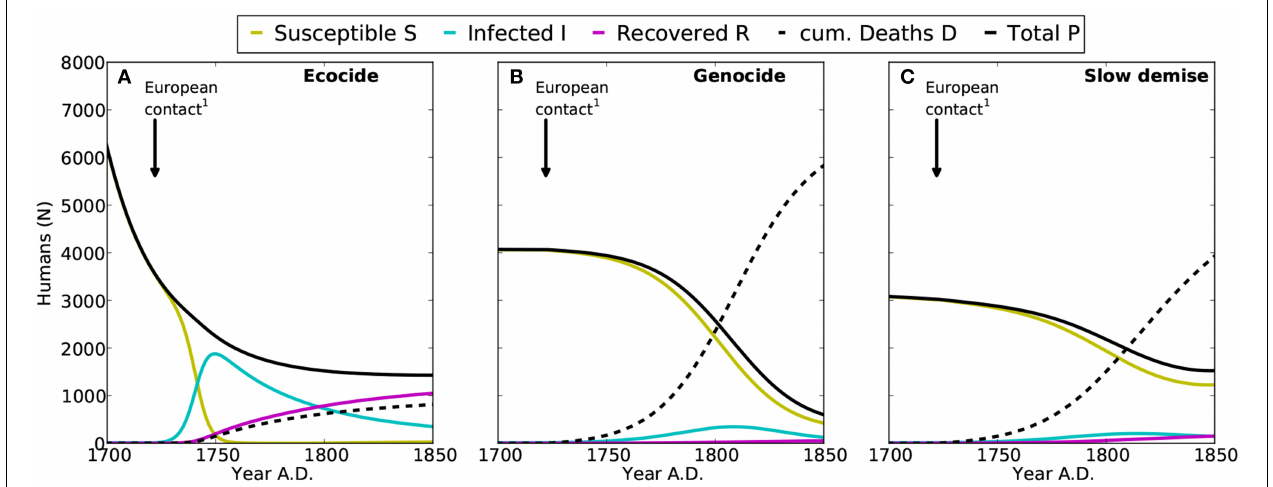
FIGURE 3 | Epidemics of introduced diseases on Easter Island after the first European contact in 1722AD. Shown are the time-series for susceptible (S, yellow), infected (I, cyan), and recovered (R, purple) humans, with the sum of S, I, and R representing the total population (P, black).